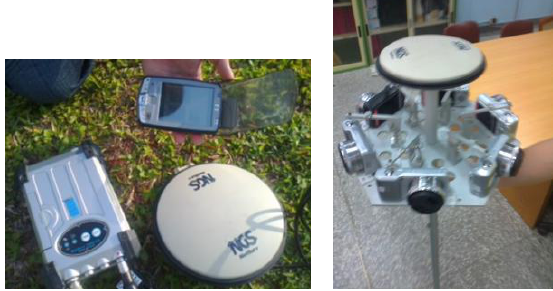
Figure 4. The use of antenna separated GPS receiver for the